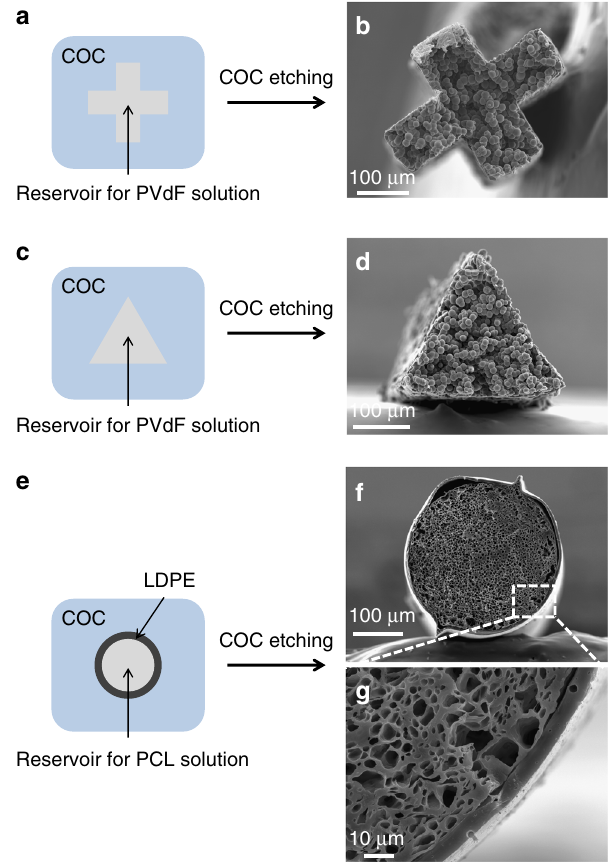
Fig. 2 Control of external geometry and architecture. ( a ) Schematic illustration of a preform with a cross-shaped reservoir for PVdF solution and ( b ) SEM micrograph of the cross-shaped porous PVdF fi ber after drawing and cladding dissolution. ( c ) Schematic illustration of a preform with a triangle-shaped reservoir for PVdF solution and ( d ) SEM micrograph of the triangle-shaped porous PVdF fi ber after drawing and cladding dissolution. ( e ) Schematic illustration of a cyclic ole fi n copolymer preform with a cylindrical reservoir for polycaprolactone (PCL) solution lined with a thin LDPE wall and ( f , g ) SEM micrographs of the fi nal porous PCL core/dense LDPE shell fi ber after drawing and cladding